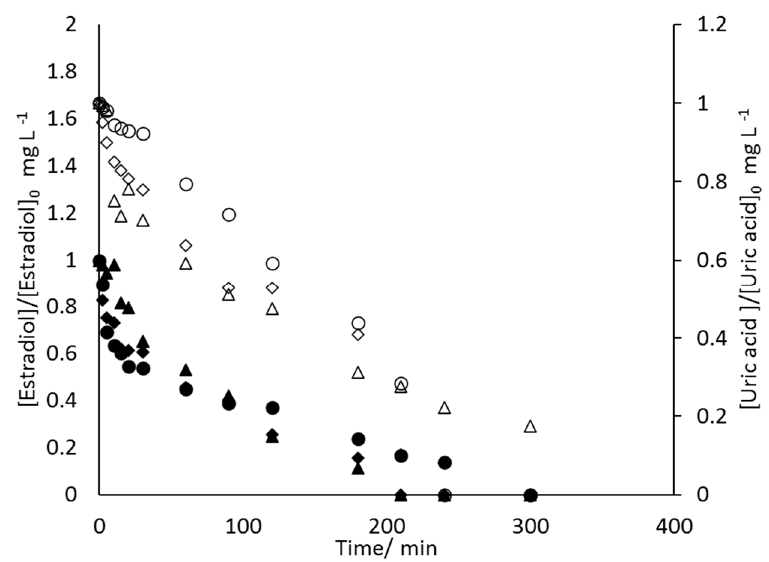
Figure 5. Changes in the concentration of 17 β -estradiol (black symbols) and uric acid (white symbols) during the electrolysis of 20 mg·L − 1 of 17 β -estradiol in synthetic urine/methanol media with BDD anodes 50 mA·cm − 2 of current density and at different flowrates: ( ▲ , ) 6.77 mL·s − 1 ; ( ● , ○ ) 11.66 mL·s − 1 ; ( ♦ , ◊ ) 12.833 mL·s − 1 .